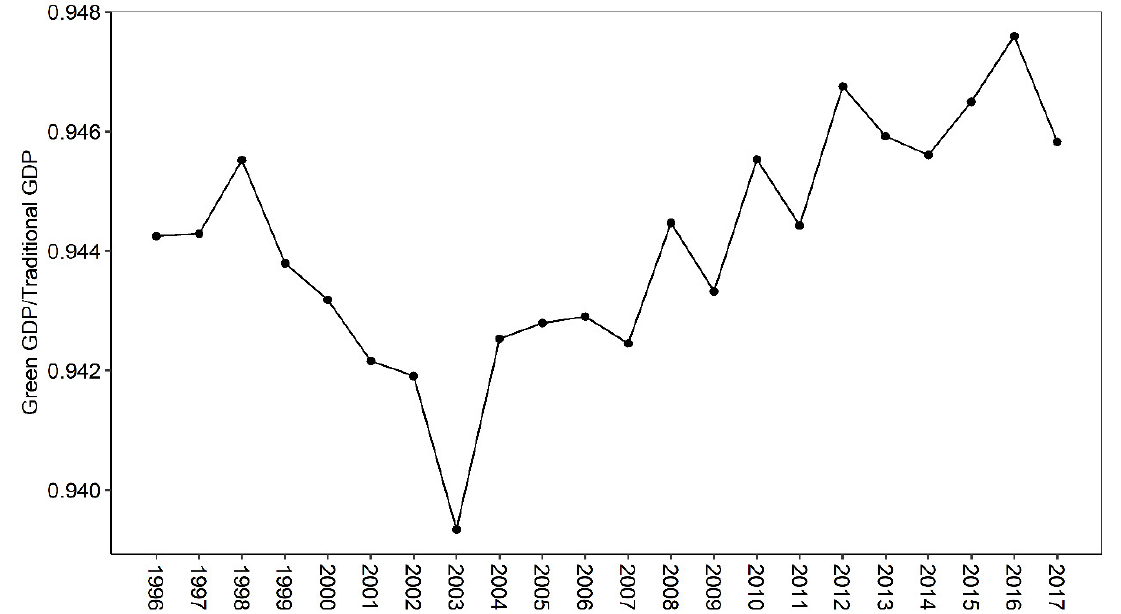
Figure 6. Trends in the rate of China’s agricultural green GDP to traditional GDP, 1996–2017. As shown in Table 8, from 1996 to 2017, the five provinces with the highest agri- cultural green GDP/traditional GDP were Tibet (0.982), Sichuan (0.97), Ningxia (0.965), Guangdong (0.962), and Anhui (0.96). Among them, three provinces are in the western,